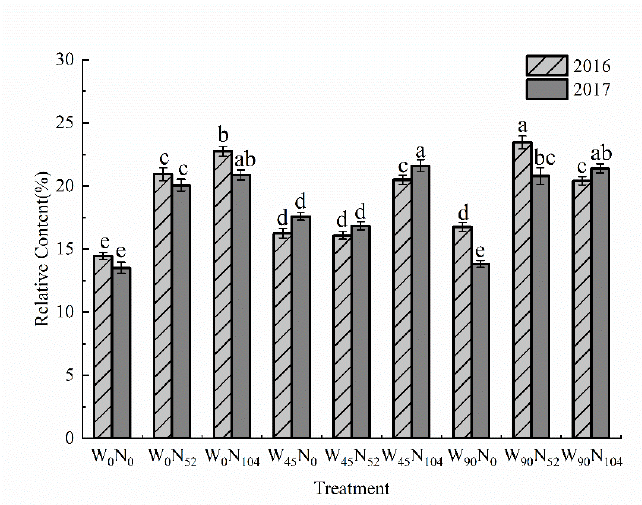
Figure 3. Influence of irrigation, nitrogen, and the interaction between the two on the total amino acid content of sunflower seed kernels (mean ± SD; different lowercase letters indicate that there are significant differences in nine treatments at the 5% level in 2016 and 2017, respectively.).